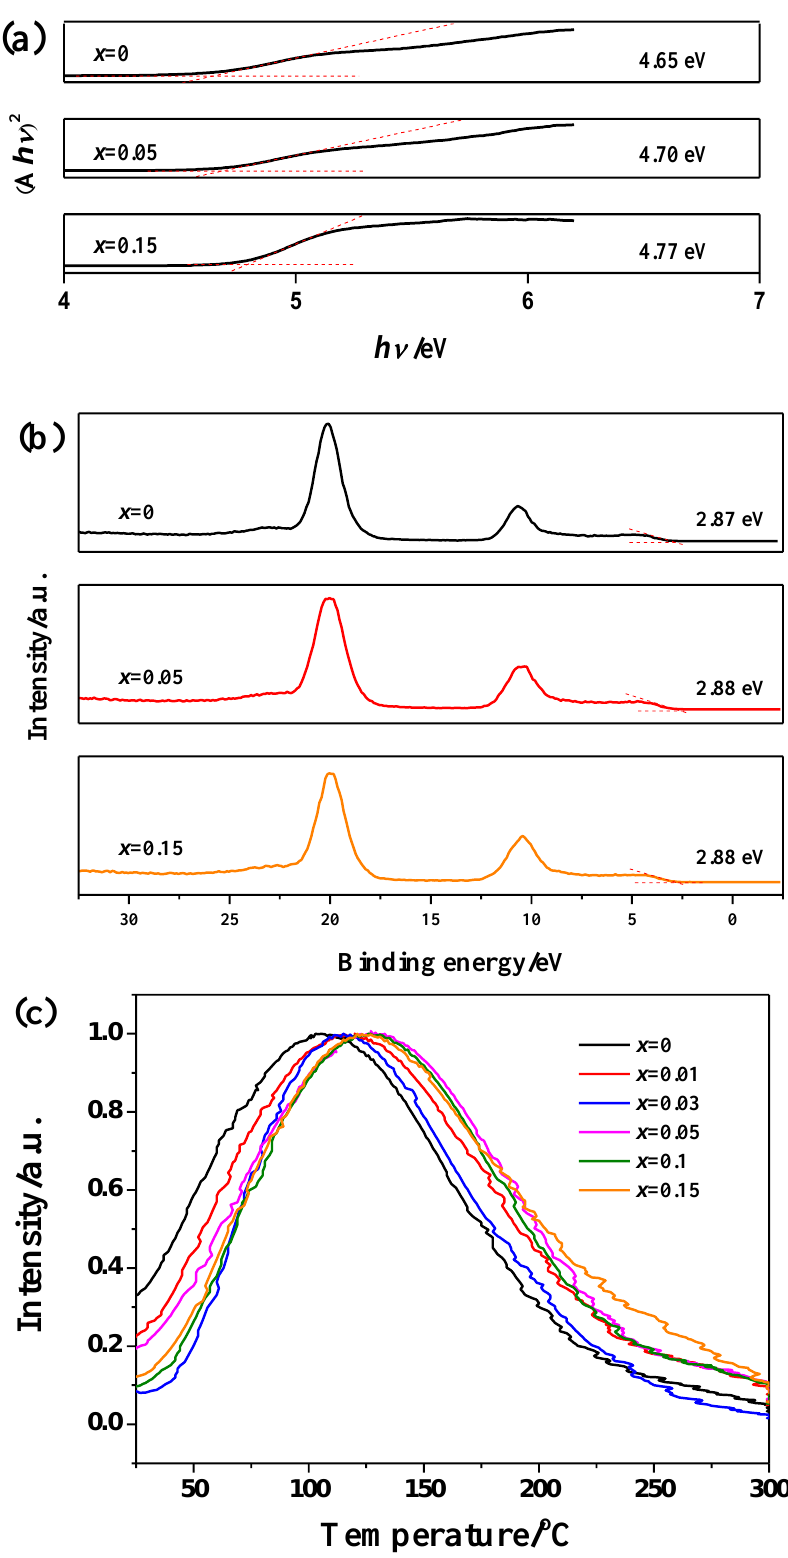
Figure 7. ( a ) Determination of bandgap energies, ( b ) Valence-band XPS spectra, and ( c ) TL glow curves of ZGMSO:Cr 3+ ( x = 0 – 0.15).